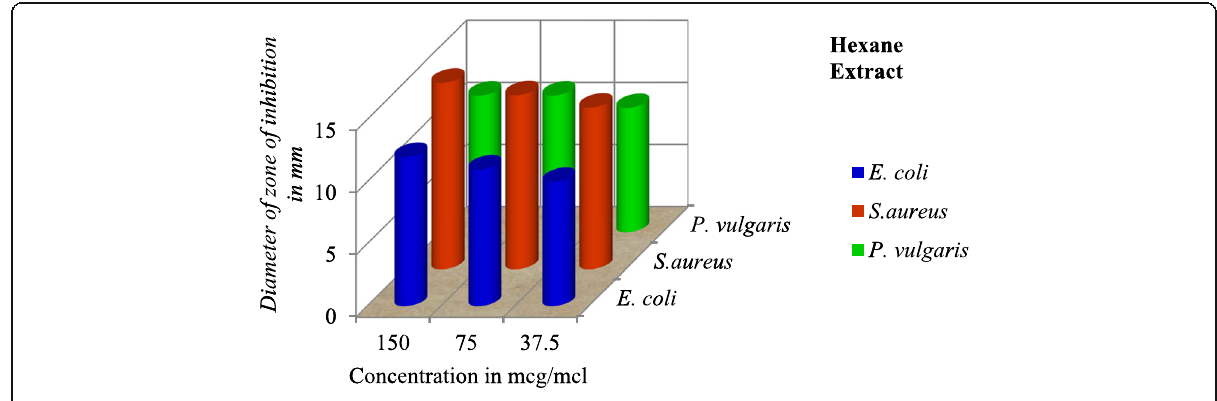
Fig. 4 Antibacterial sensitivity of hexane extract